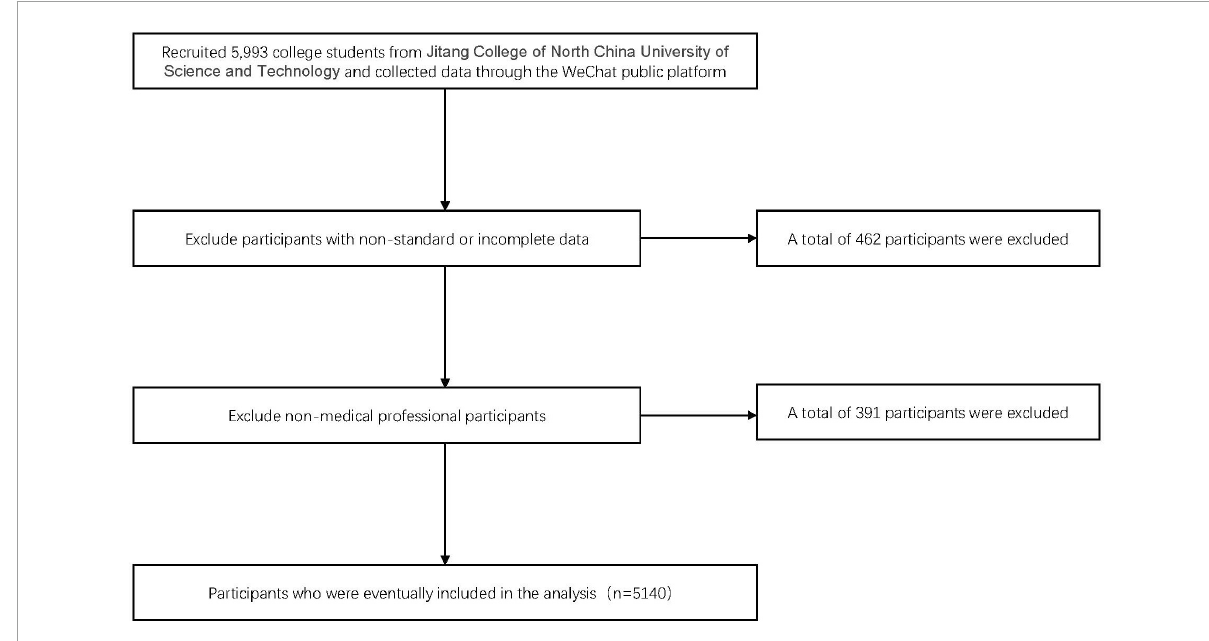
FIGURE1 Flow chart of sample selection according to inclusion and exclusion